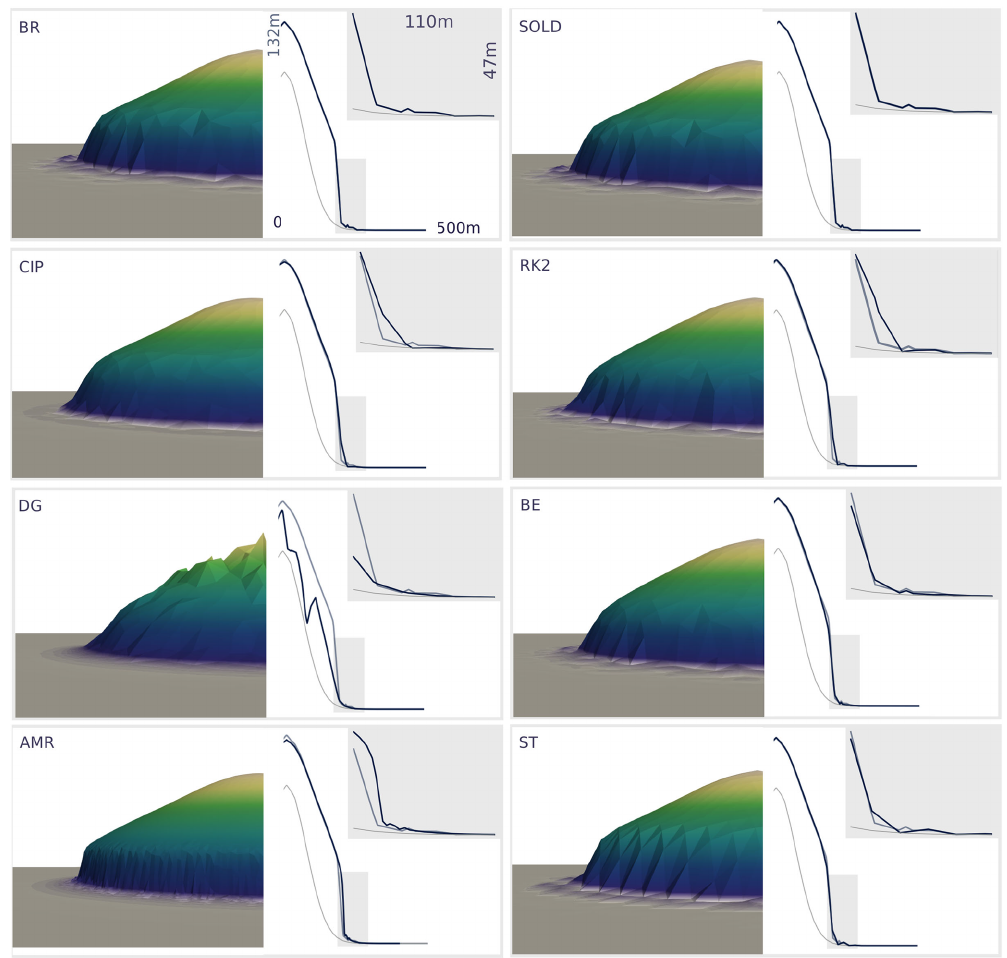
Figure 14. The left panels show results of the hill test for stabilised simulations after 24 years using BR (bubble-enriched), CIP (continuous interior penalty), DG (discontinuous Galerkin), AMR (adaptive mesh refinement), SOLD (oscillations at sharp layer diminishing), RK2 (Runge–Kutta time discretisation), BE (backward Euler time discretisation) and ST (structured mesh). The right panels show a cross-profile along the y axis of surface (blue) and bed (grey) elevation; insets show a zoom of the opaque grey regions; the bold grey line indicates the reference solution using the SUPG and Crank–Nicholson setup (see also Fig.